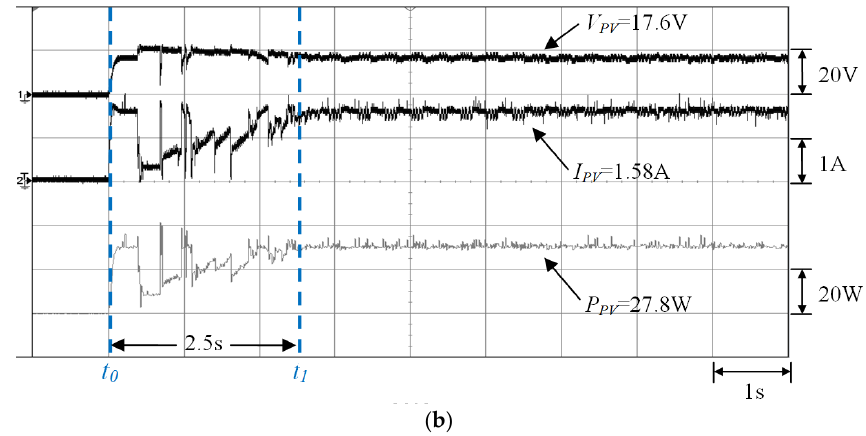
Figure 12. Measurement results of the one-serial and one-parallel module array with 0% shading by using ( a ) conventional TLBO ( P mp = 27.4 W) and ( b ) the proposed I-TLBO ( P mp = 27.8 W).